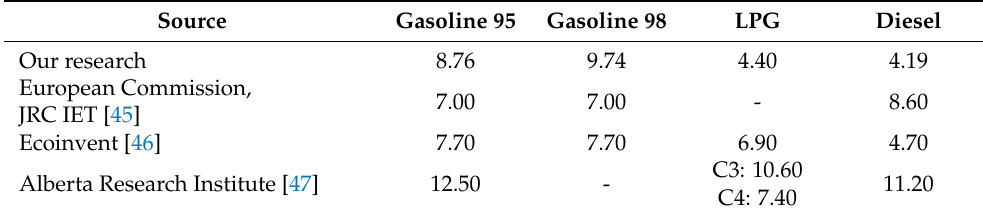
Table 4. GHG emissions from motor fuels by sources [gCO 2